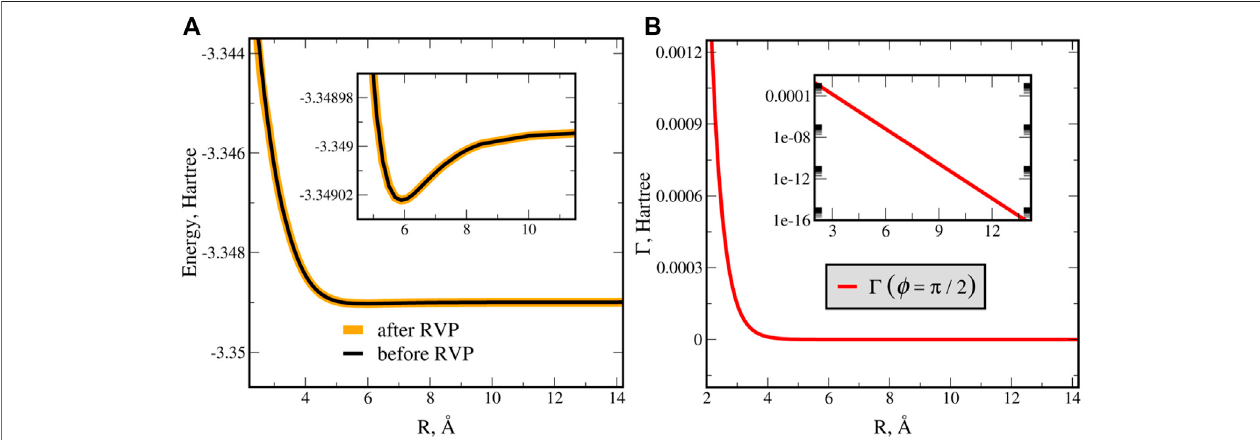
FIGURE 9 | The RVP complex potential energy surface in T-shape ( ϕ = π /2) geometry of He( 3 S,1s2s) + H 2 . The real part is presented in panel (A) , where the inset zooms into the shallow well. The orange curve (the real part (Re E ( R )) of the complex RVP curve) and the black curve (the approximated Hermitian calculations) are in agreement. The imaginary part, i.e., the decay rate ( Γ ( R ) = − 2Im E ( R )), is presented in panel (B) . The decay rate fi ts into a single exponential curve (see inset in logarithmic scale), which con fi rms that this autoionization is a Penning ionization [79]. Reprinted (adapted) with permission Ref. [67]. Copyright (2017) American Chemical